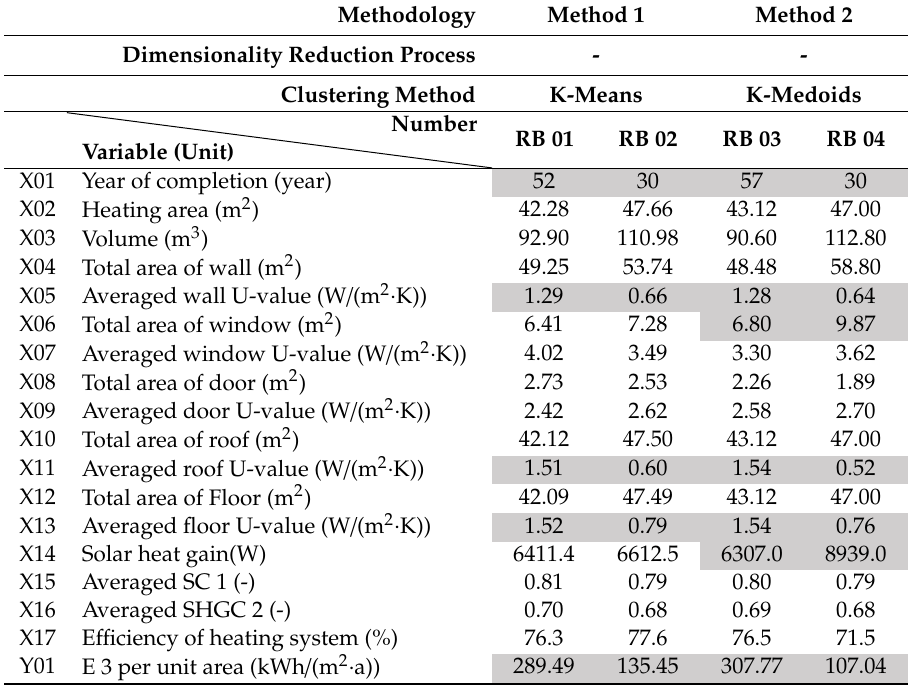
Table 4. Standard model derived through methods 1 and 2.